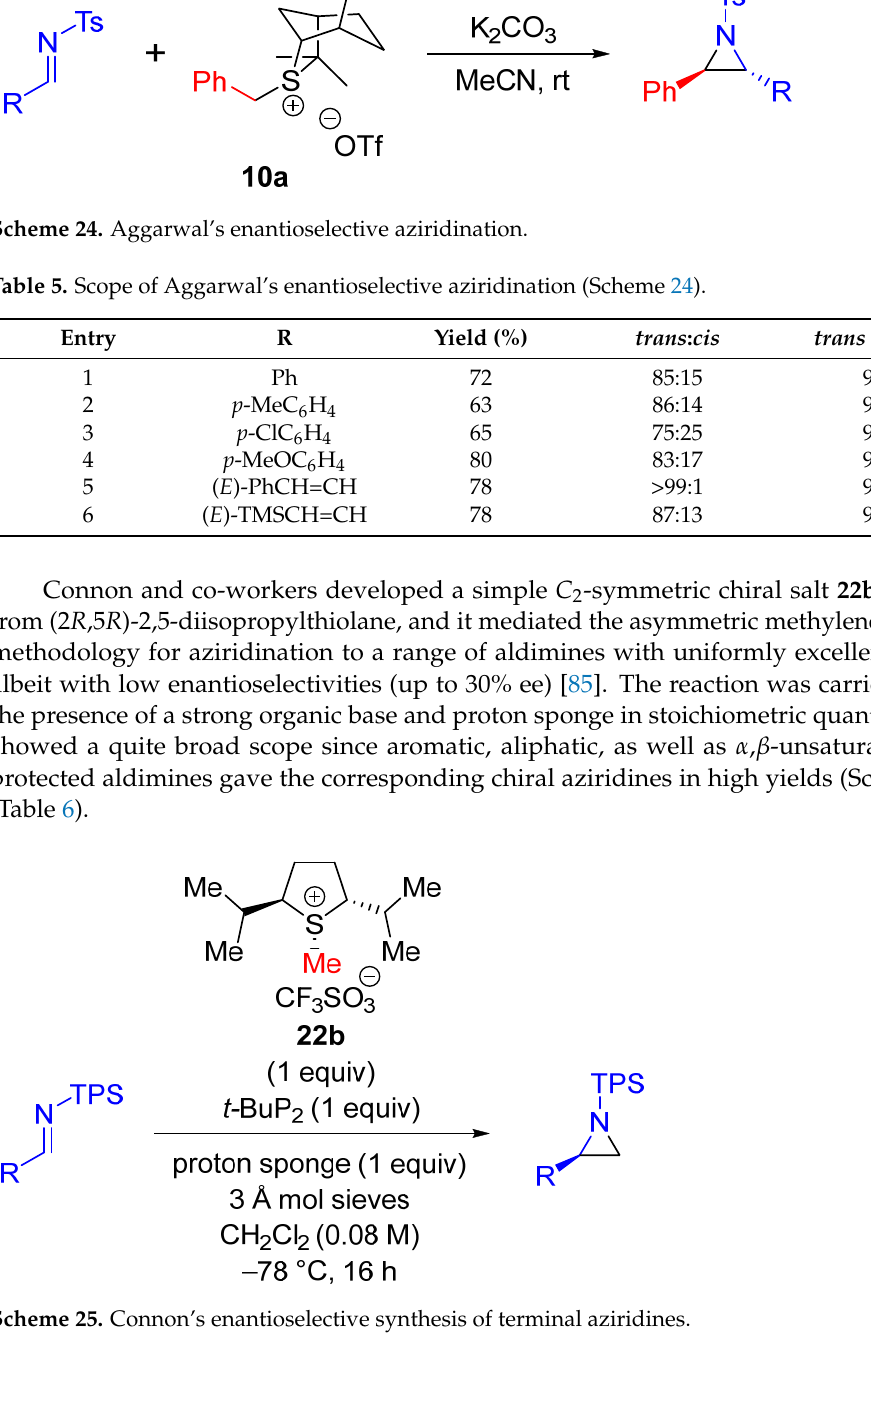
Scheme 25. Connon’s enantioselective synthesis of terminal aziridines.